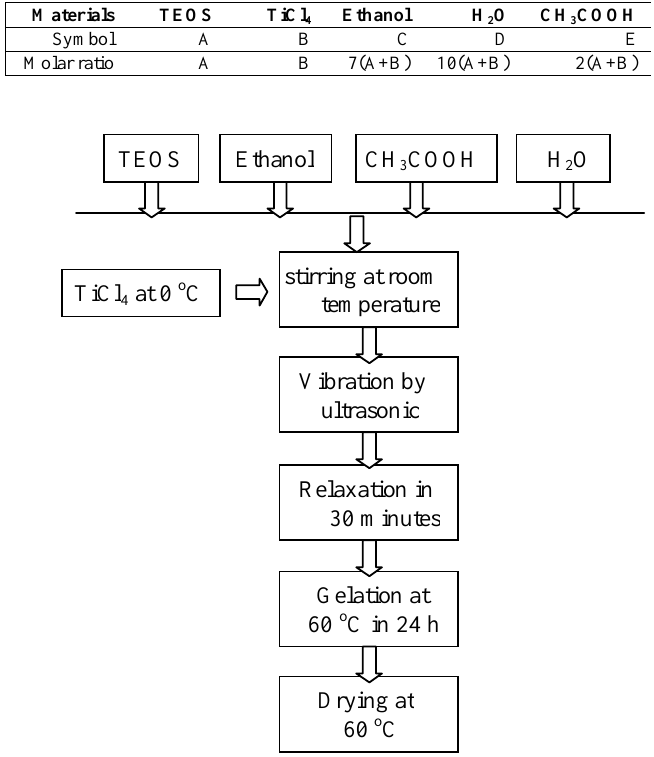
Table 1 : Materials and corresponding molar ratio.